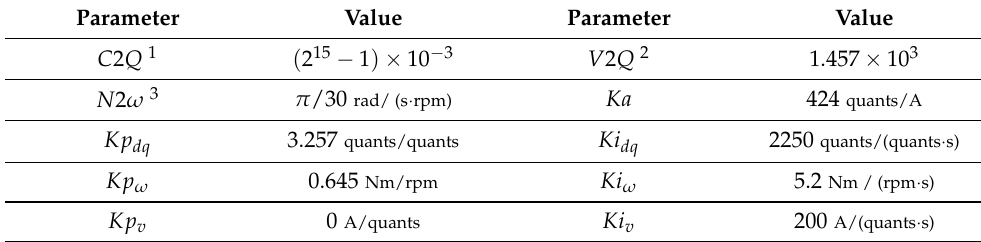
Table 5. Controllers Design in the inverter’s system of